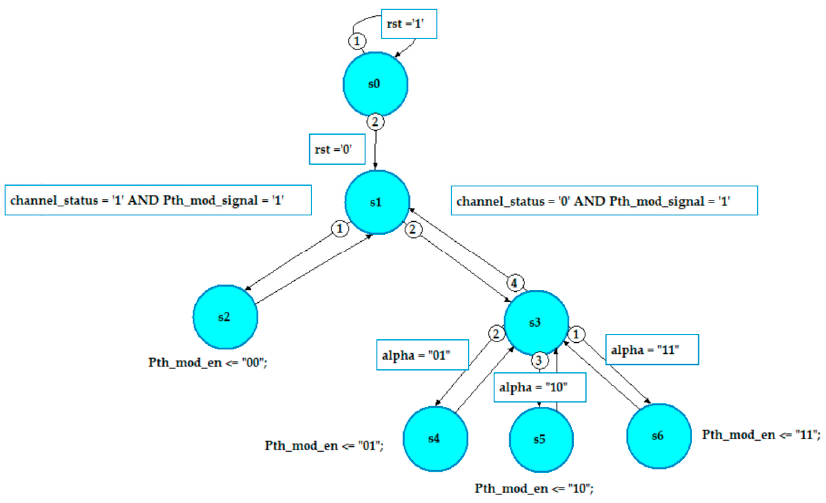
Figure 11. FSM for the proposed channel_packet_status block.